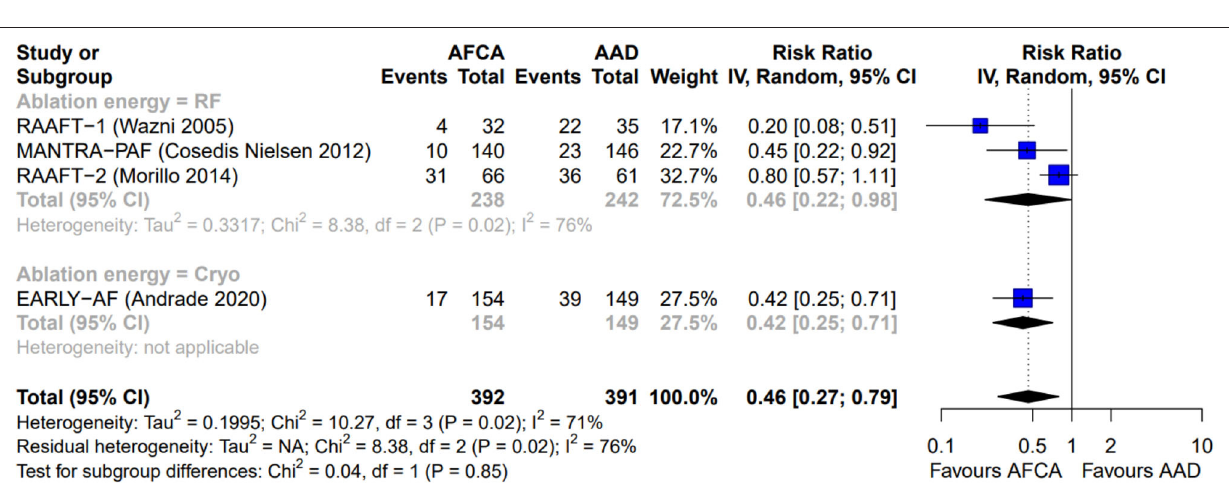
did not differ between AFCA and AAD groups (0.5 vs. 0.7%,